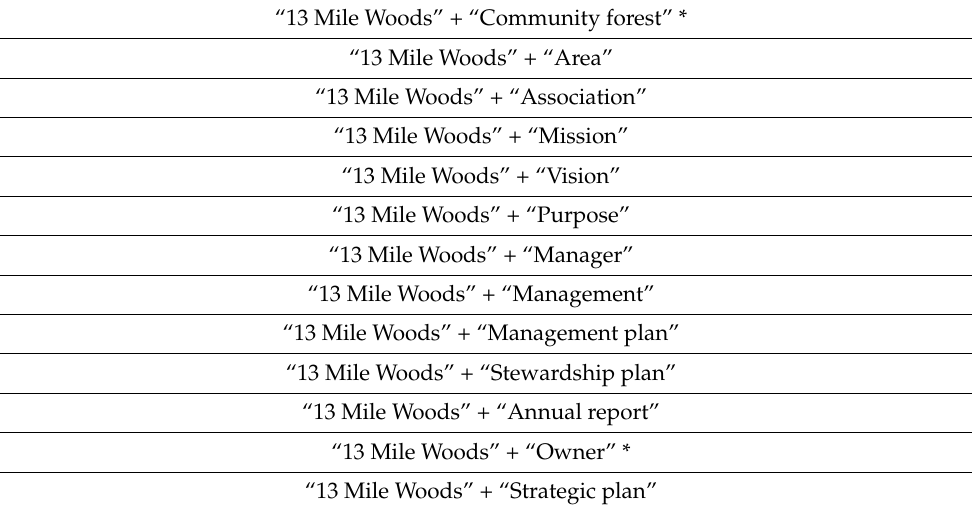
Table A1. Keywords used in systematic search, using 13 mile woods community forest as an